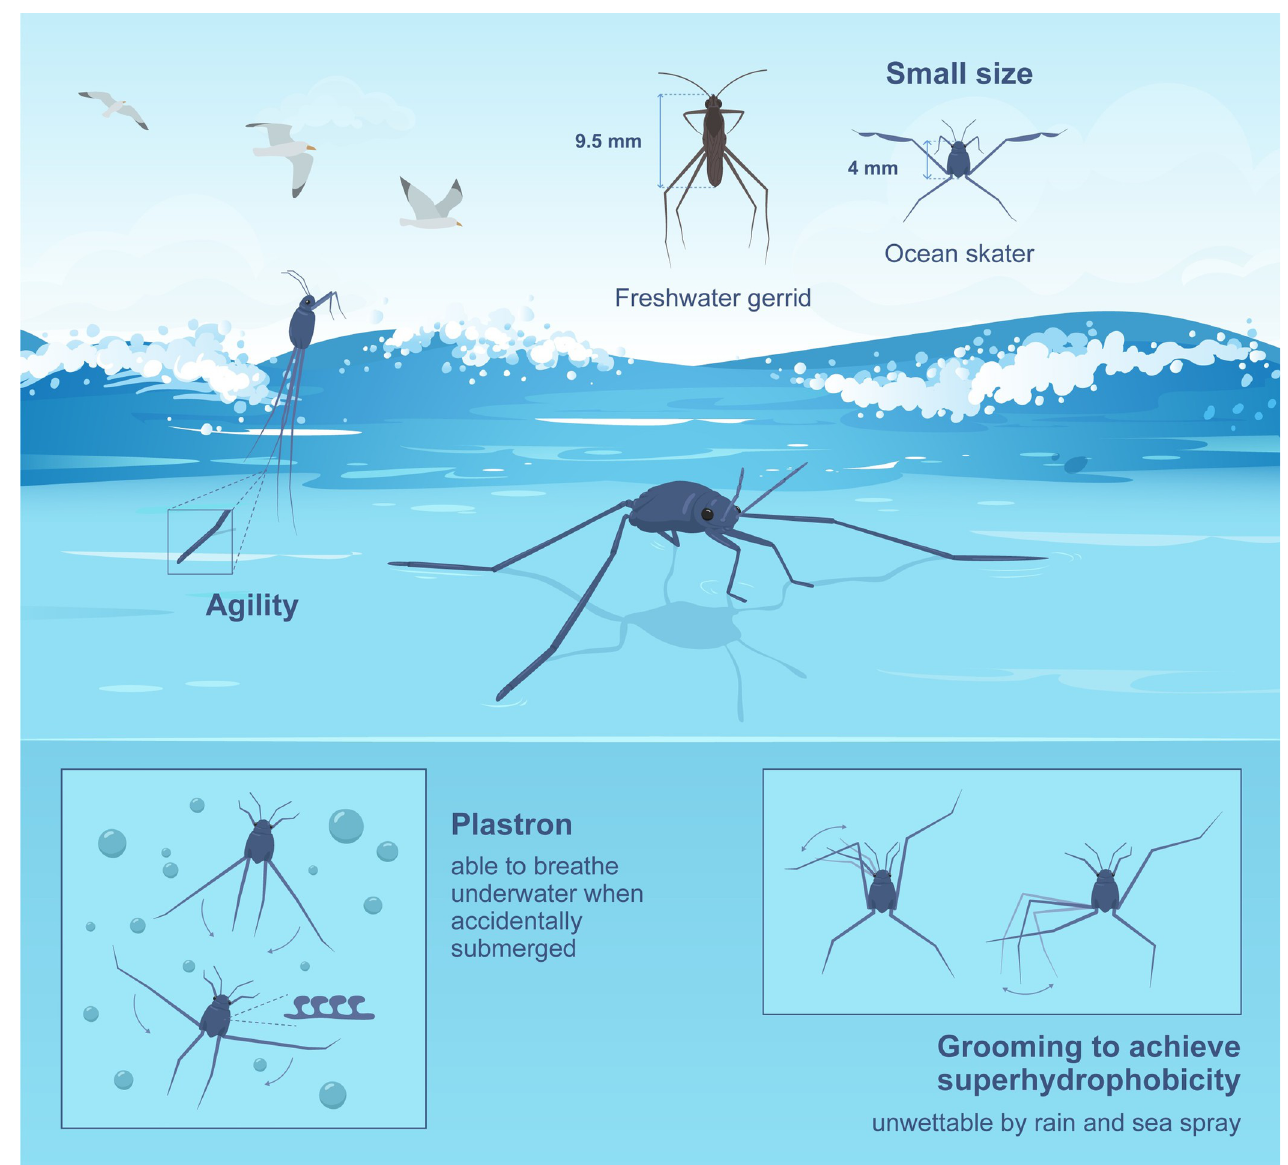
Fig 3. Key adaptations of ocean skaters ( Halobates ). Clockwise from the top right corner. Halobates have a small size and reduced body length/width ratio. They are oval and less than half the size of common freshwater skaters but with very similar leg lengths. This adaptation facilitates faster accelerations and higher speeds when moving. Frequent grooming to spread waxy secretion over their body hairs renders them superhydrophobic (or ultra-water repellent), which prevents wetting by sea-sprays and raindrops, allowing Halobates to fully exploit the water surface tension for jumping and skating. When accidentally submerged, the club-shaped hairs (microtrichia) covering their body entrap a layer of air (known as the plastron), allowing Halobates to breathe underwater and to resurface. They are also incredibly agile and are able to achieve impressive acceleration and height to evade dangers. Illustration adapted from a figure created by Xavier Pita in Mahadik and colleagues [29]